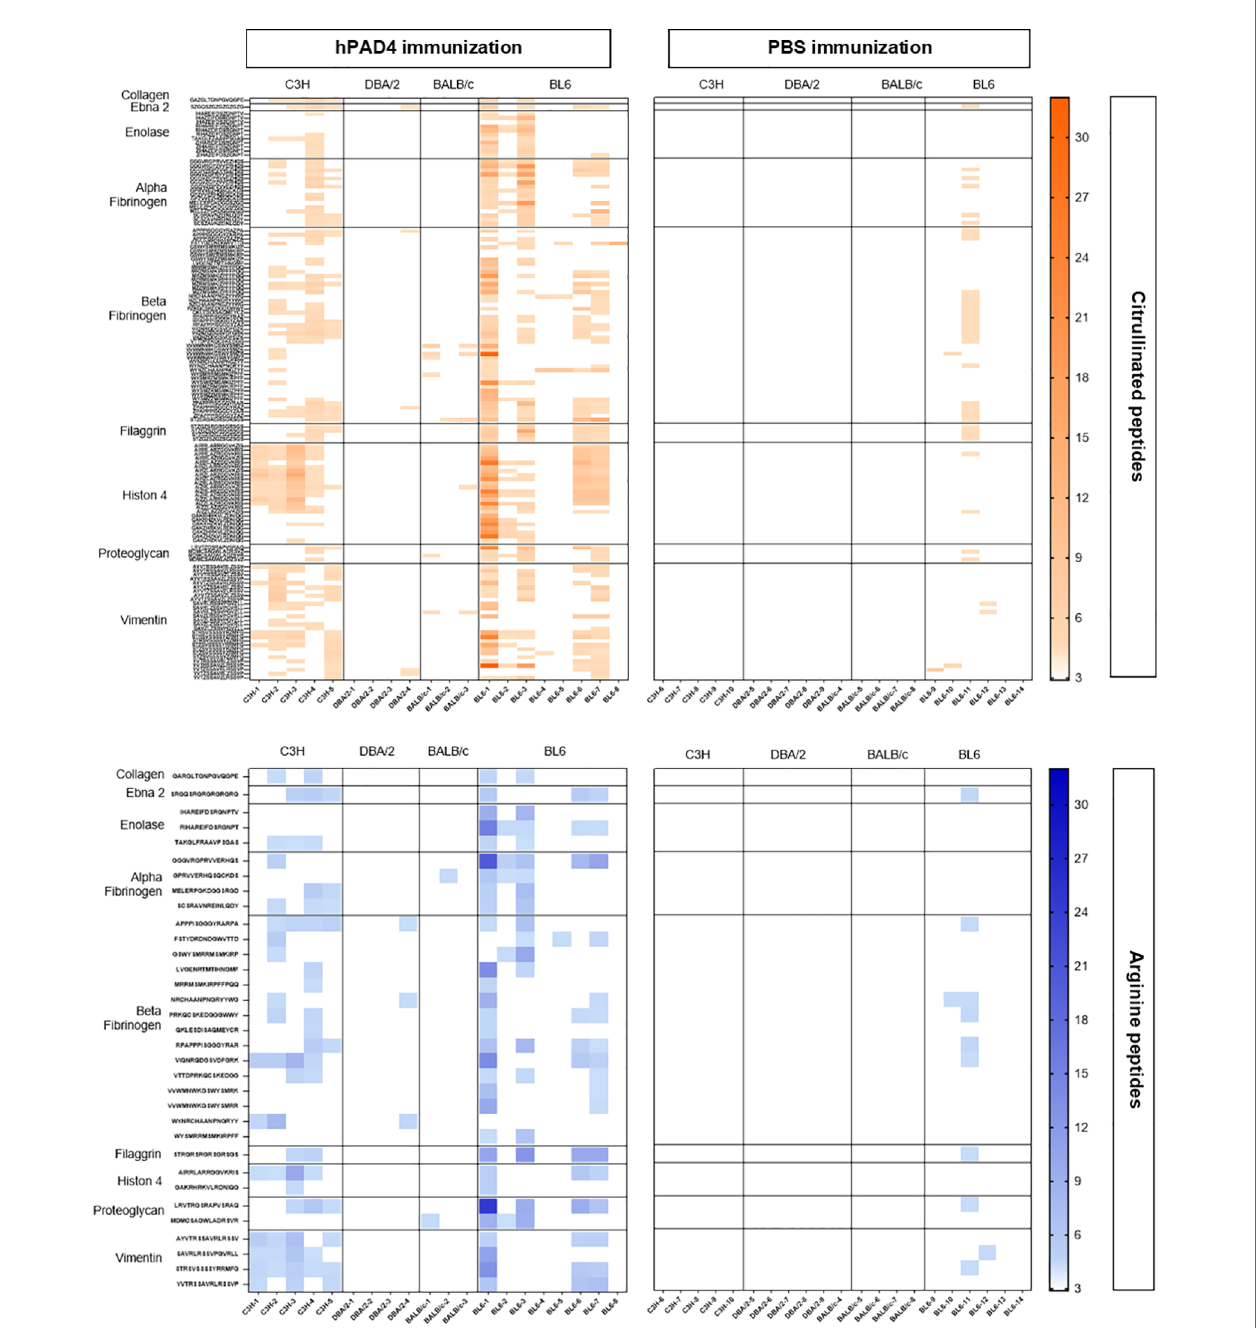
FIGURE 3 | Heatmap of anti-arginine and citrullinated IgG responses in mice immunized with hPAD4 or PBS. A heatmap diagram was computed with ratios (mean test signal/mean background signal) in a color-coded manner from white (no binding) to red (strong binding) for citrullinated peptides and from white (no binding) to blue (strong binding) for arginine peptides. X-axis represents mice (on the left, mice immunized with hPAD4, on the right, mice immunized with PBS), Y-axis represents